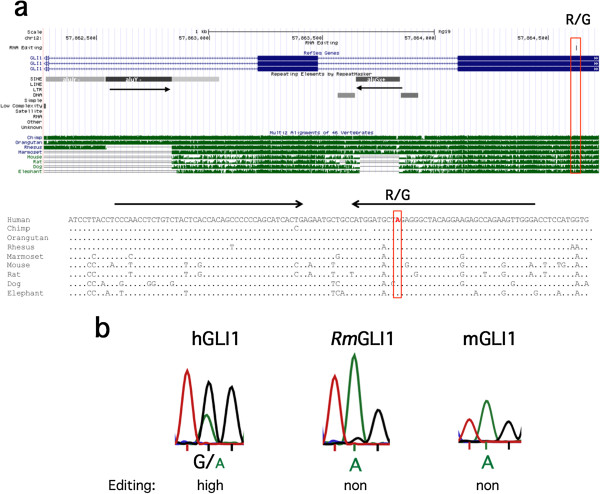
Inverted Alus and site-selective editing in GLI1. (a) UCSC genome browser view. Inverted Alu elements are annotated with their family and strandedness in the repetitive elements by RepeatMasker track, and marked with black arrows. While the most downstream alu (aluSx+) is present in all primates, the two upstream alus (aluJr- and aluY-) are absent in some of them (non-apes), as indicated by the Multiz Alignment track. The non-Alu editing site is shown in a red rectangle. Bottom: The sequence flanking the non-Alu editing site. (b) Sanger sequencing after RT-PCR on GLI1 transcripts from human (hGLI1), rhesus (RmGLI1) and mouse (mGLI1) brains. Editing was detected as a dual A and G peak in the chromatograms. kb, kilobase; R/G, arginine to glycine; RT-PCR, reverse transcription polymerase chain reaction.